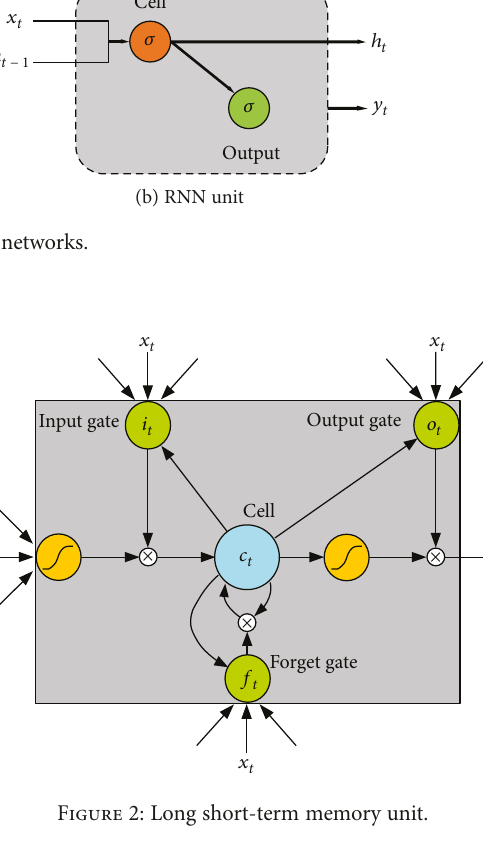
Figure 2: Long short-term memory unit.